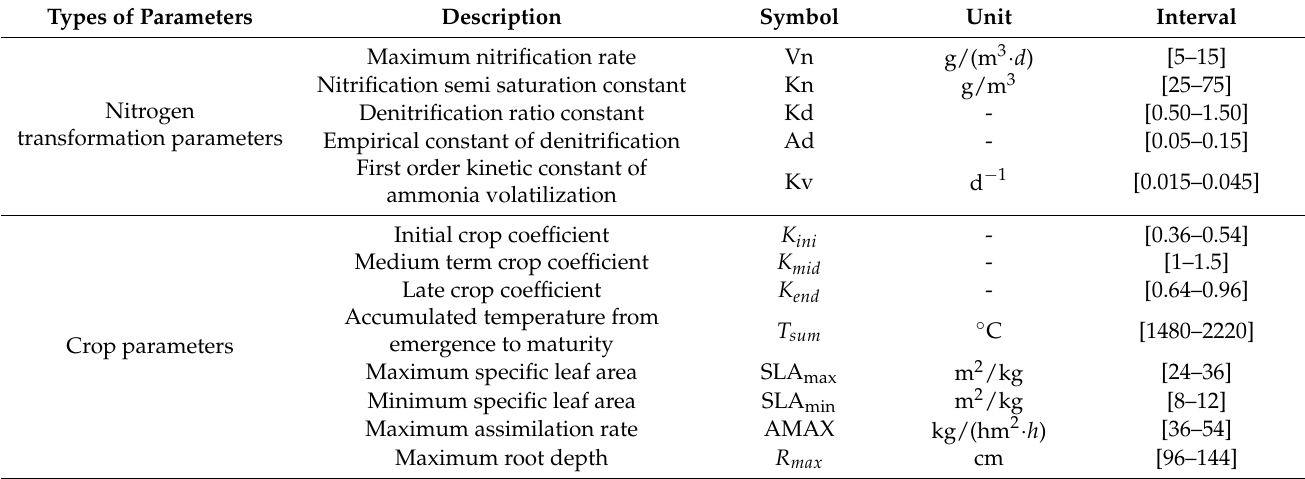
Table 2. Nitrogen transformation and crop parameters selected for